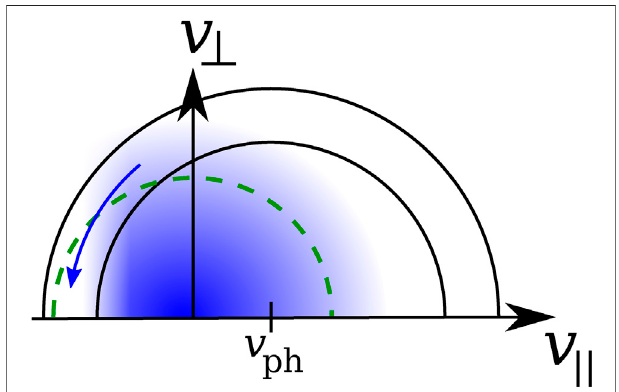
FIGURE 11 | Schematic illustration of the quasi-linear diffusion in the electron-de fi cit whistler instability. The blue shaded area represents the electron population with a de fi cit at v (cid:2) < 0. The black semi-circles represent Eq. 17 for parallel-propagating fast-magnetosonic/whistler waves with parallel phase speed v ph . The diffusive fl ux of cyclotron-resonant particles is shown by the blue arrow. The green-dashed semi-circle indicates v 2 ⊥ + v 2 (cid:2) (cid:3)